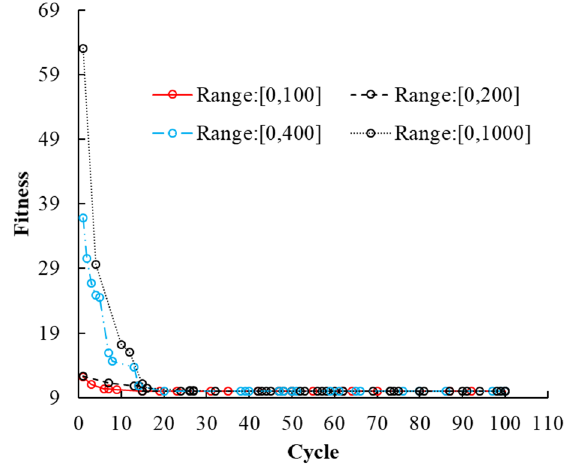
Figure 11. The convergence in different searching ranges.